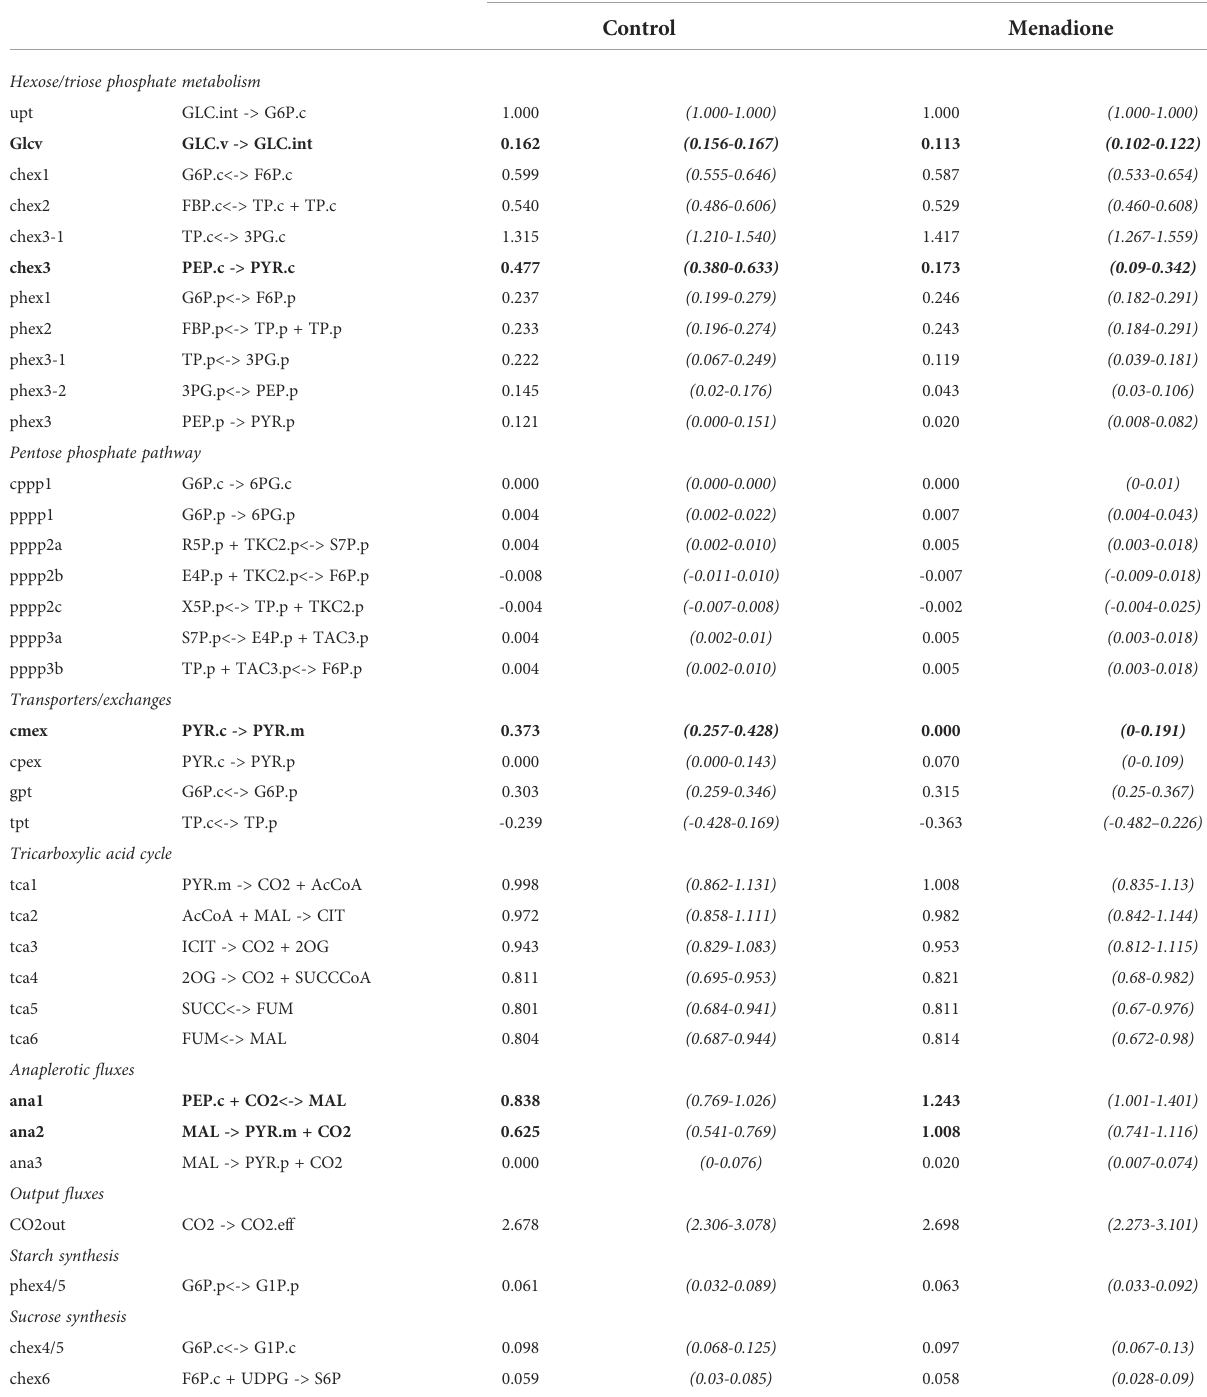
TABLE 2 Global best- fi t fl ux estimates for heterotrophic arabidopsis cell cultures treated with 60 µM menadione for 6 h or an untreated control. Fluxes were deduced using INST-MFA following supply of [ 13 C 6